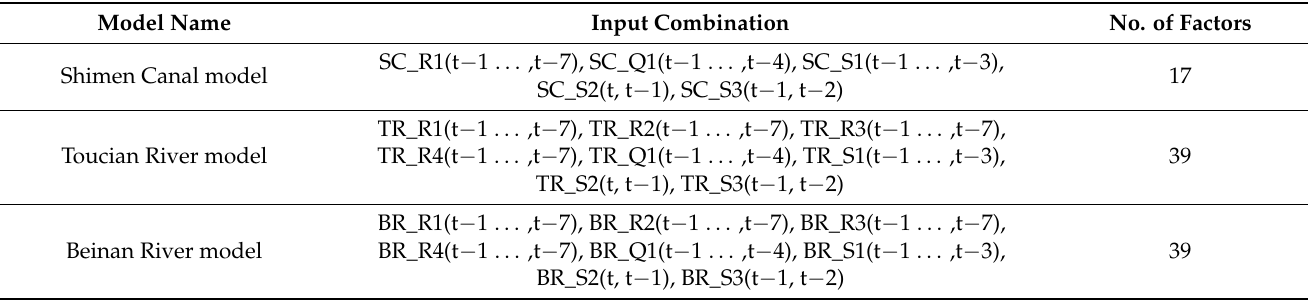
Table 7. ANN models and their input factors for various